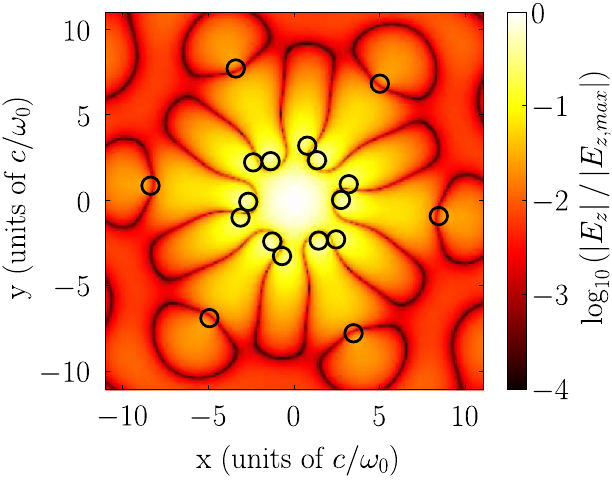
FIG. 3. (Color) Axial electric field strength in the optimized PhC cavity. The 18 black rings indicate the positions and diameters of the dielectric rods (cf. Fig.